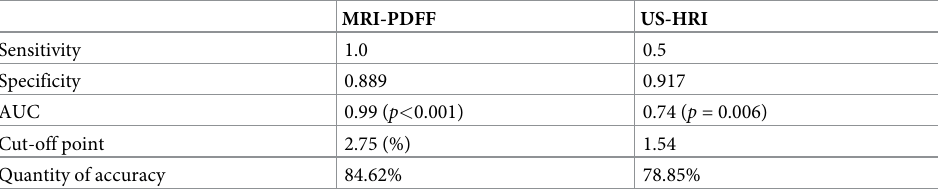
Table 1. Diagnostic performance of US-HRI and MRI-PDFF.